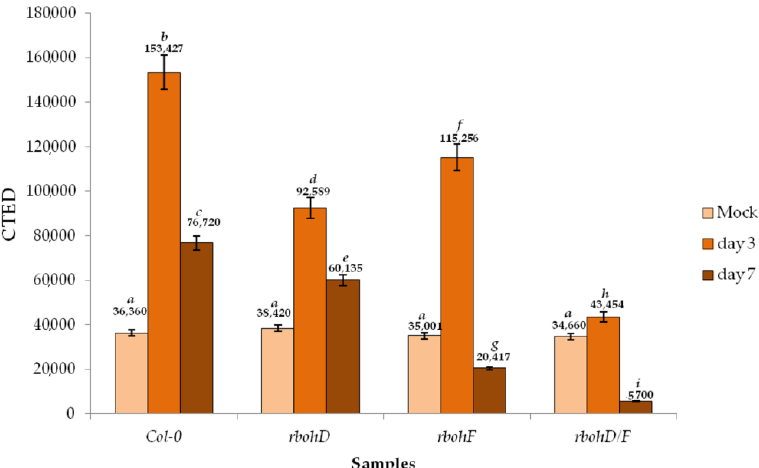
Figure 14. Corrected total electron density (CTED) of cerium (IV) perhydroxide precipitate in mock- and TuMV-inoculated Arabidopsis thaliana Col-0, rbohD , rbohF and double mutant rbohD / F at 3 and 7 dpi. Significant di ff erences between classes at p < 0.05 level of significance by ANOVA with post-hoc Tukey HSD were assessed. The statistical significant values are marked by letters above chart